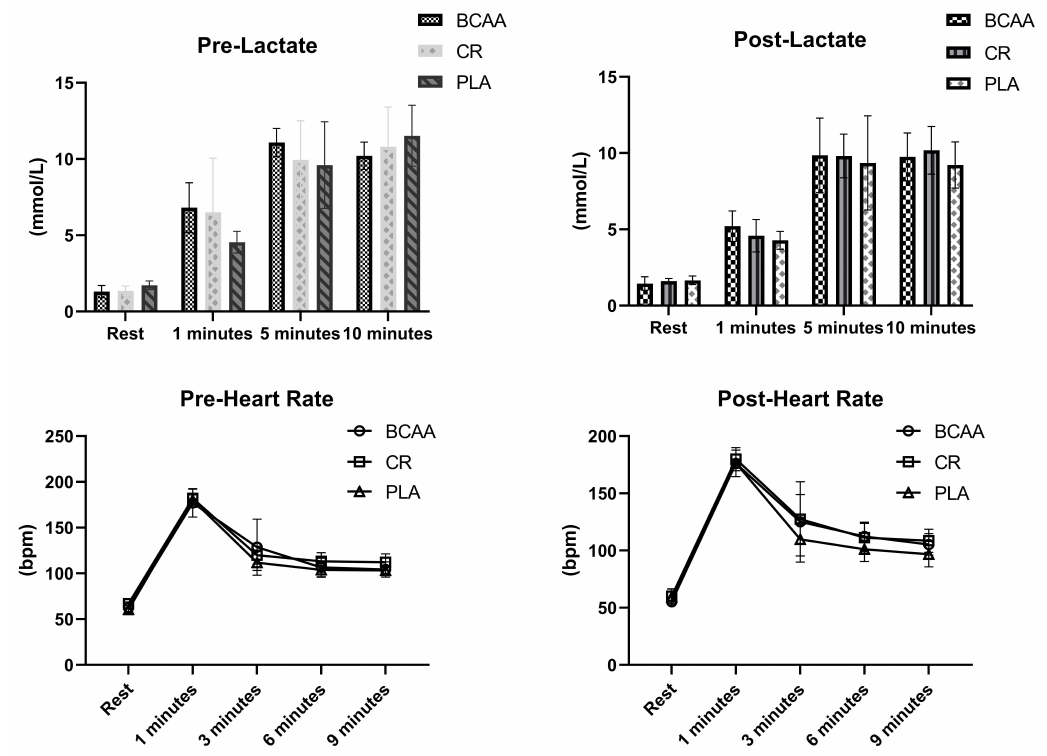
Fig. 2. The heart rate and lactate levels at different time points in rest and after exercise during recovery periods . BCAA, branched- chain amino acids group; CR, creatine group; PLA, placebo group; Pre, pre-supplementation period; Post, post-supplementation period. Values are mean ± SD. *Significant ( p < 0.05) difference in pre-and post-supplementation periods between BCAA, CR, and PLA